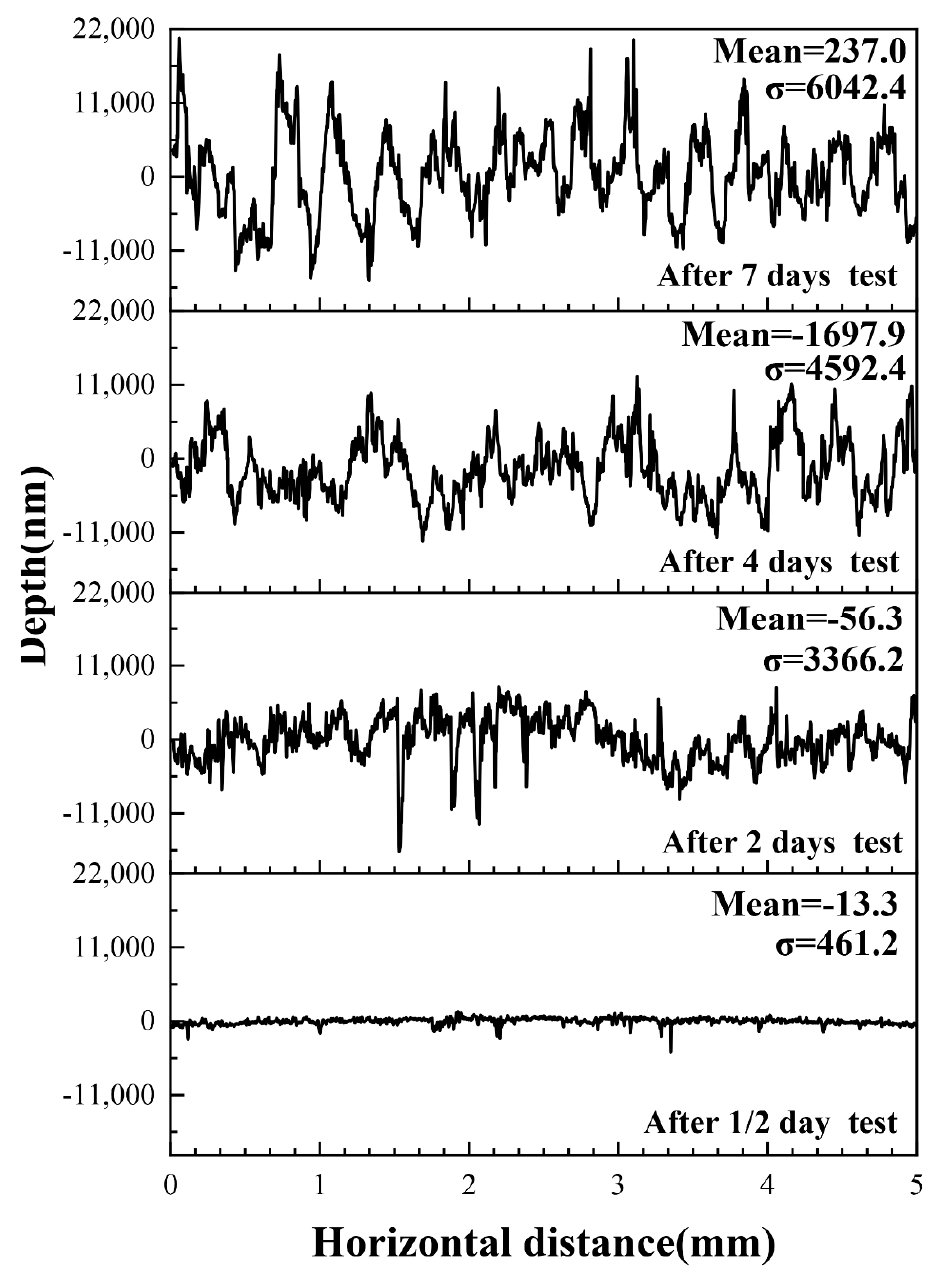
Figure 14. Linear profile of the matrix surface of L245N standard steel after different times.